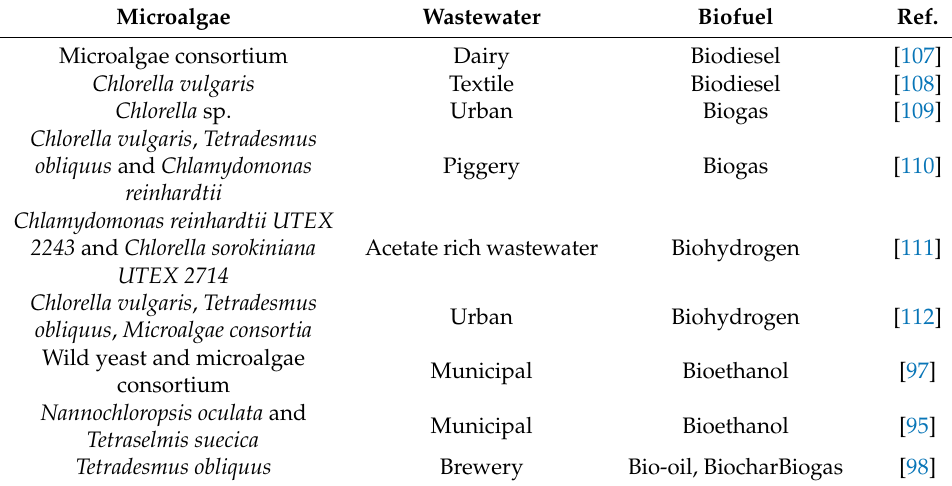
Table 6. Biofuels produced in wastewater cultured microalgae. Microalgae Wastewater Biofuel